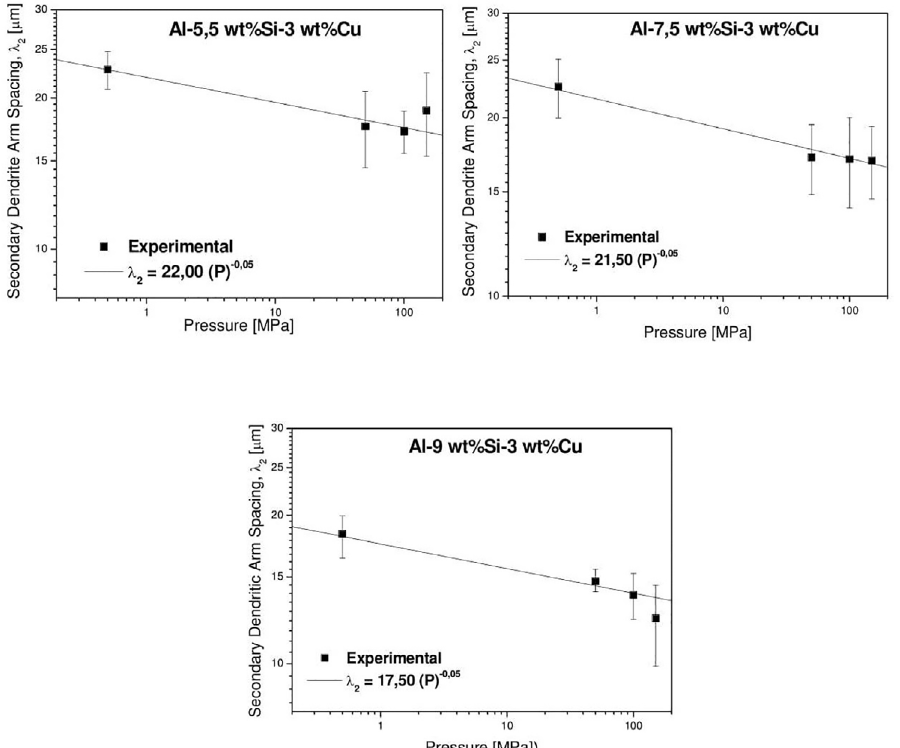
Figure 6. Espaçamento dendriticos secundário em função da pressão. (a) Al-5,5%wtSi-3%wtCu, (b) Al-7,5%wtSi- 3%wtCu e (c)